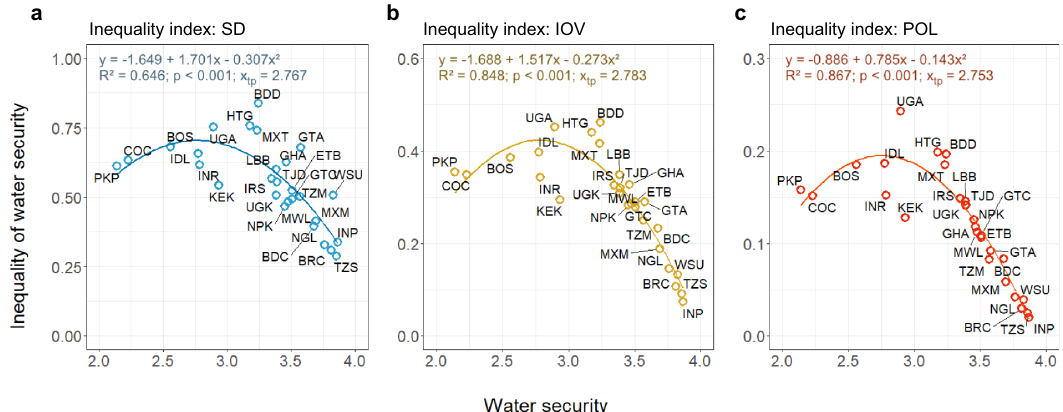
Fig. 2 Inverted U-shaped relationship between site water security and the inequality of household water security within each site. The inequality of water security was evaluated by a standard deviation (SD), b index of ordinal variation (IOV), and c polarisation (POL). Sample size = 28. The relationships were tested by quadratic regression models. A more stringent two-sided p -value threshold at 0.01 was used to counteract the potential problem of multiple comparisons. The three- fi gure panels demonstrate similar inverted U-shaped distributions ( p < 0.001), suggesting a robust and consistent Kuznets-like relationship between water security and its